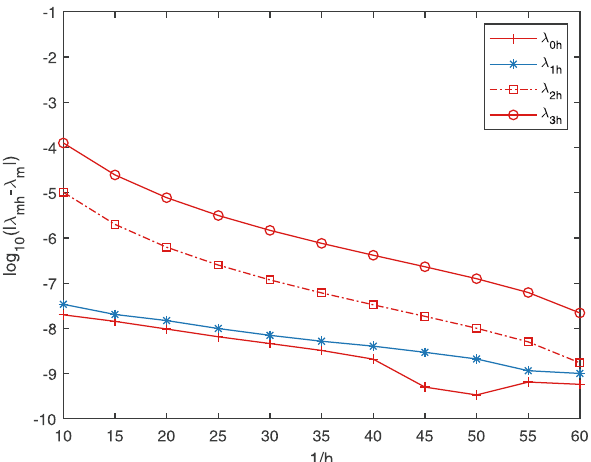
Figure 3: Error curves in semilog scale between the numerical solution and the reference solution for = R 1 .